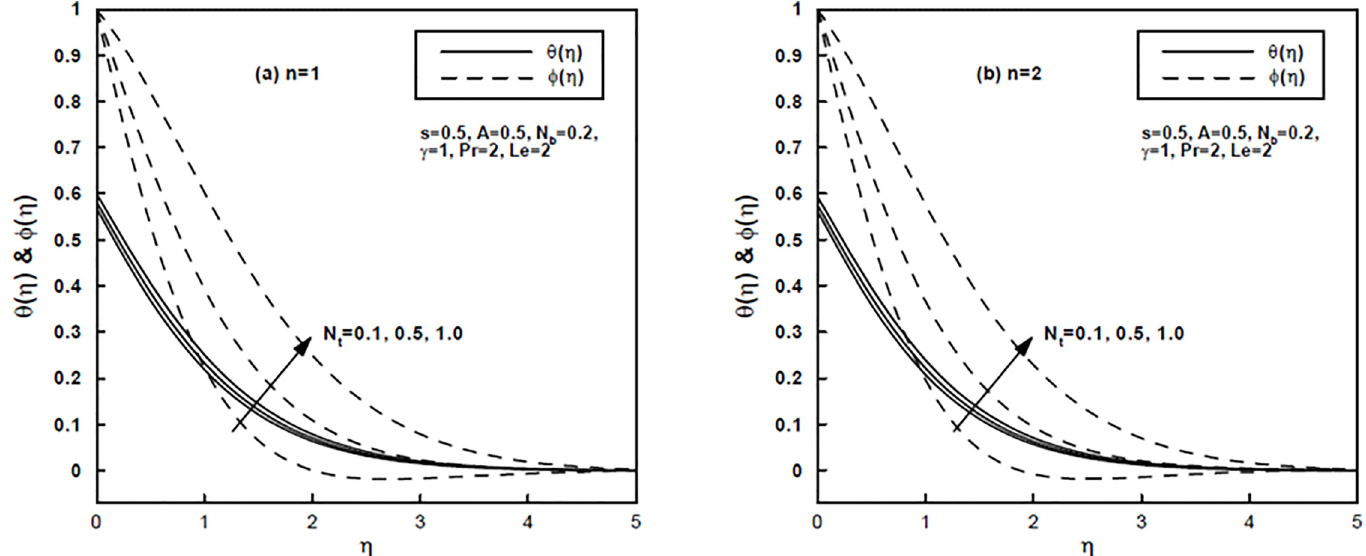
Fig 6. (a,b), The temperature and concentration profiles for different values of the thermophoresis parameter N t